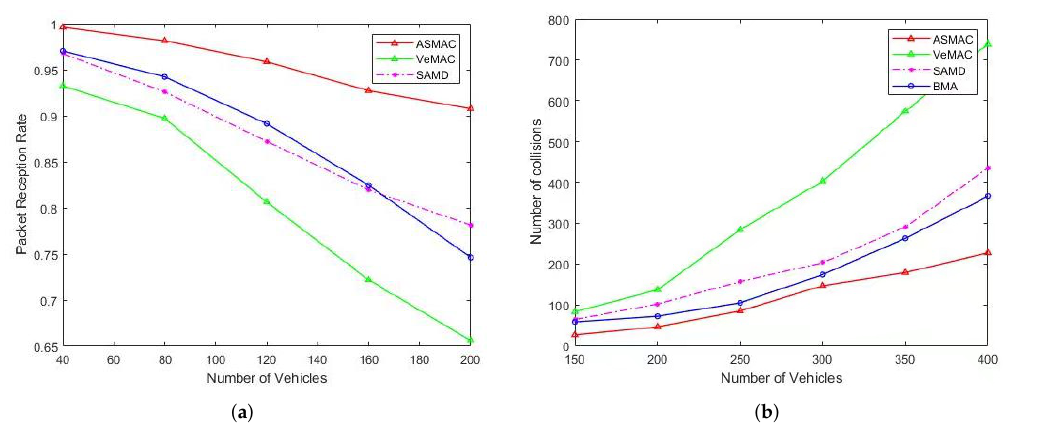
Figure 7. Packet reception rate and the number of collision on highway. ( a ) Packet reception rate. ( b )